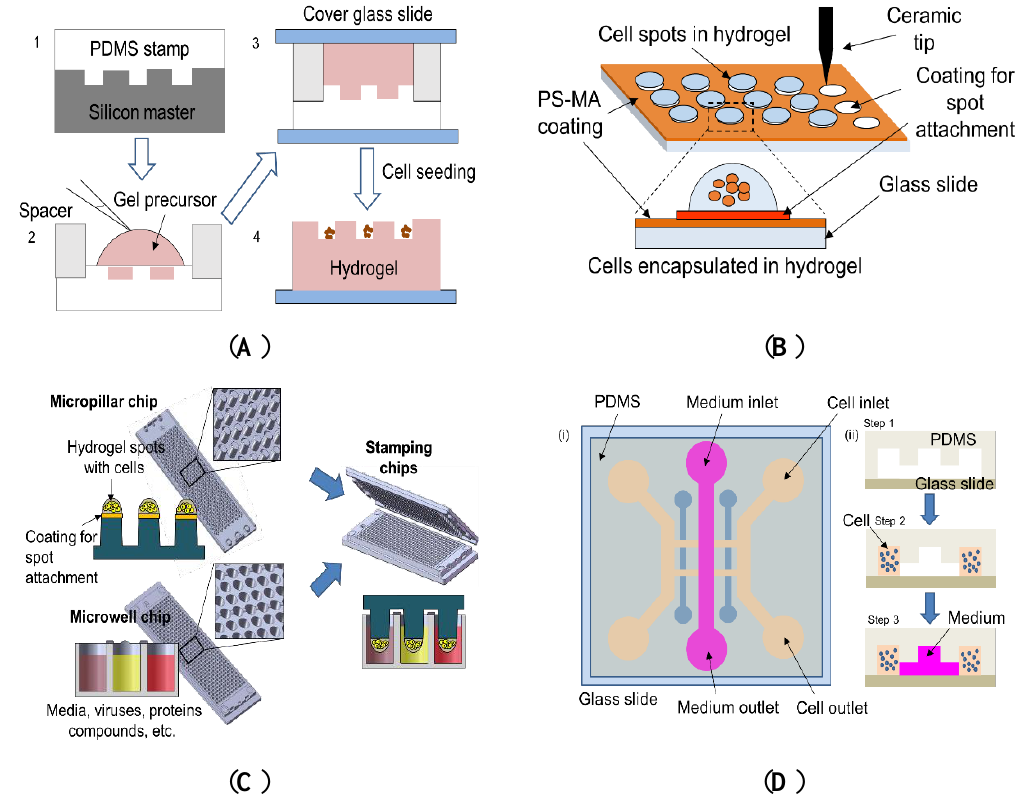
Figure 2. Miniaturized 3D cell culture systems for HCI. ( A ) Microwell platform